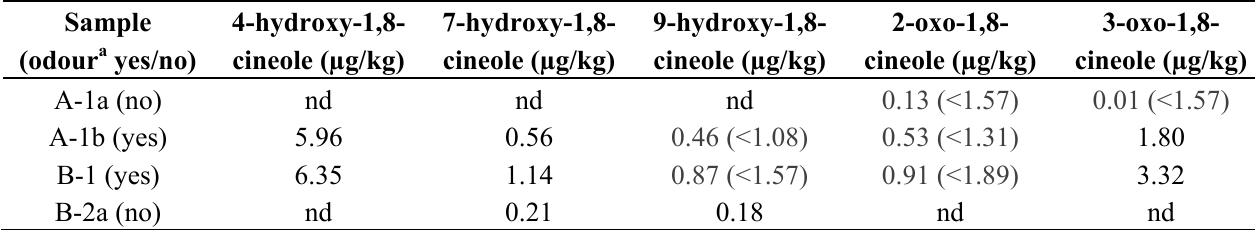
Table 2. Absolute concentrations of metabolites of 1,8-cineole in human milk samples (single